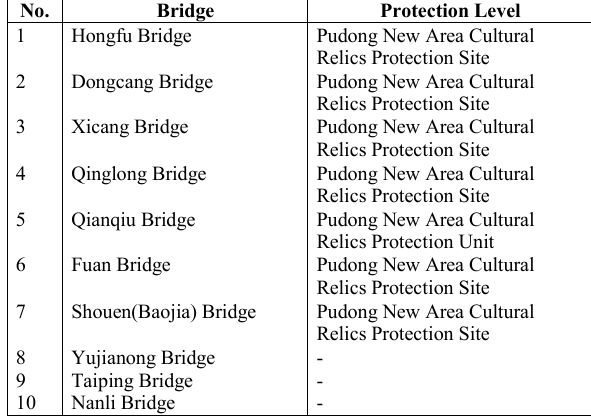
Table 2 . The old bridges selected as the viewpoints for the viewshed tool. (Part of the complete data, proposed by Chinese